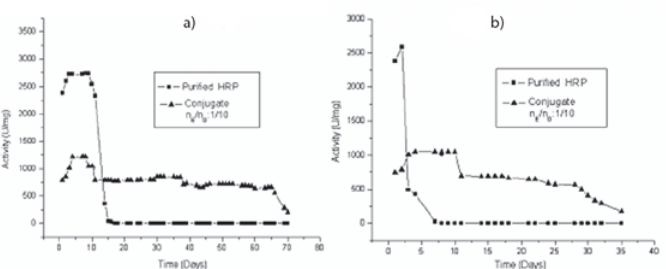
Figure 5. Storage lifetimes of purified enzyme and the conjugate with n activity measurements were carried out for each day and were